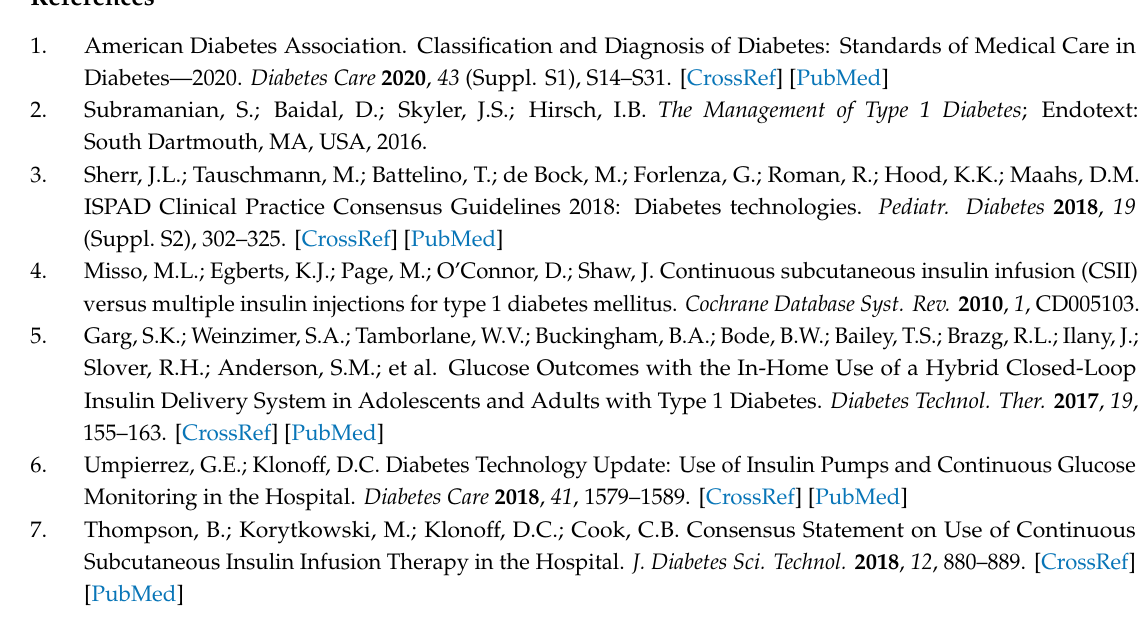
Table S1: Post Hoc Analysis for the knowledge score ( n = 307), Table S2: Post Hoc Analysis for the knowledge score (cont’d.) ( n = 307), Table S3: Post Hoc Analysis for the knowledge score (cont’d.), Table S4: Post Hoc Analysis for the attitude score ( n =